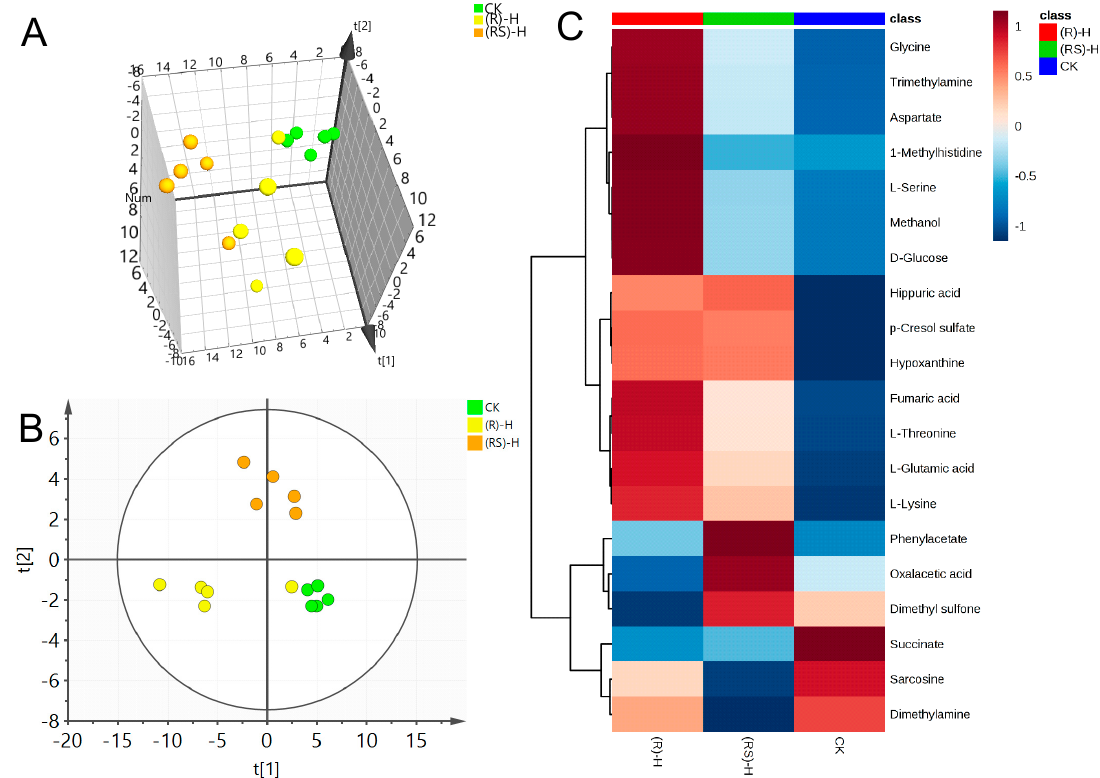
Figure 3. ( A ) Plots for PCA score, ( B ) Plots for PLS-DA score and ( C ) heat map of earthworm metabolites after exposure to high (50 mg/kg) concentration of metalaxyl or metalaxyl-M. (RS)-H: 50 mg/kg Metalaxyl, (R)-H: 50 mg/kg Metalaxyl-M.